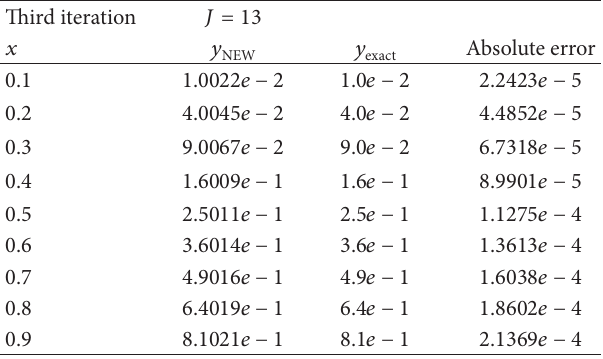
Table 1: Comparison of exact solution 𝑦 wavelet-Galerkin method with quasilinearization technique 𝑦 at second iteration: level of resolution 𝐽 = 13 and 𝐷16 is used as Galerkin